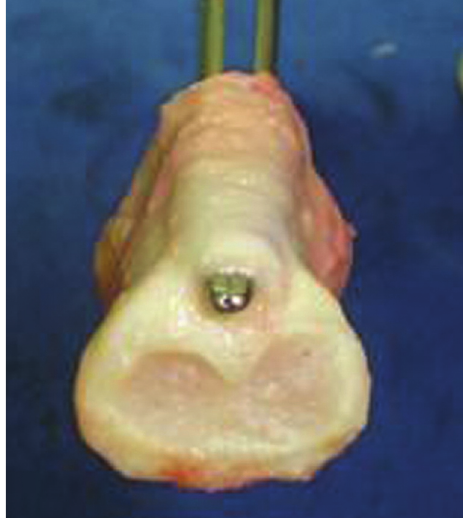
Figure 2 – Corpora cavernosa and urethra.